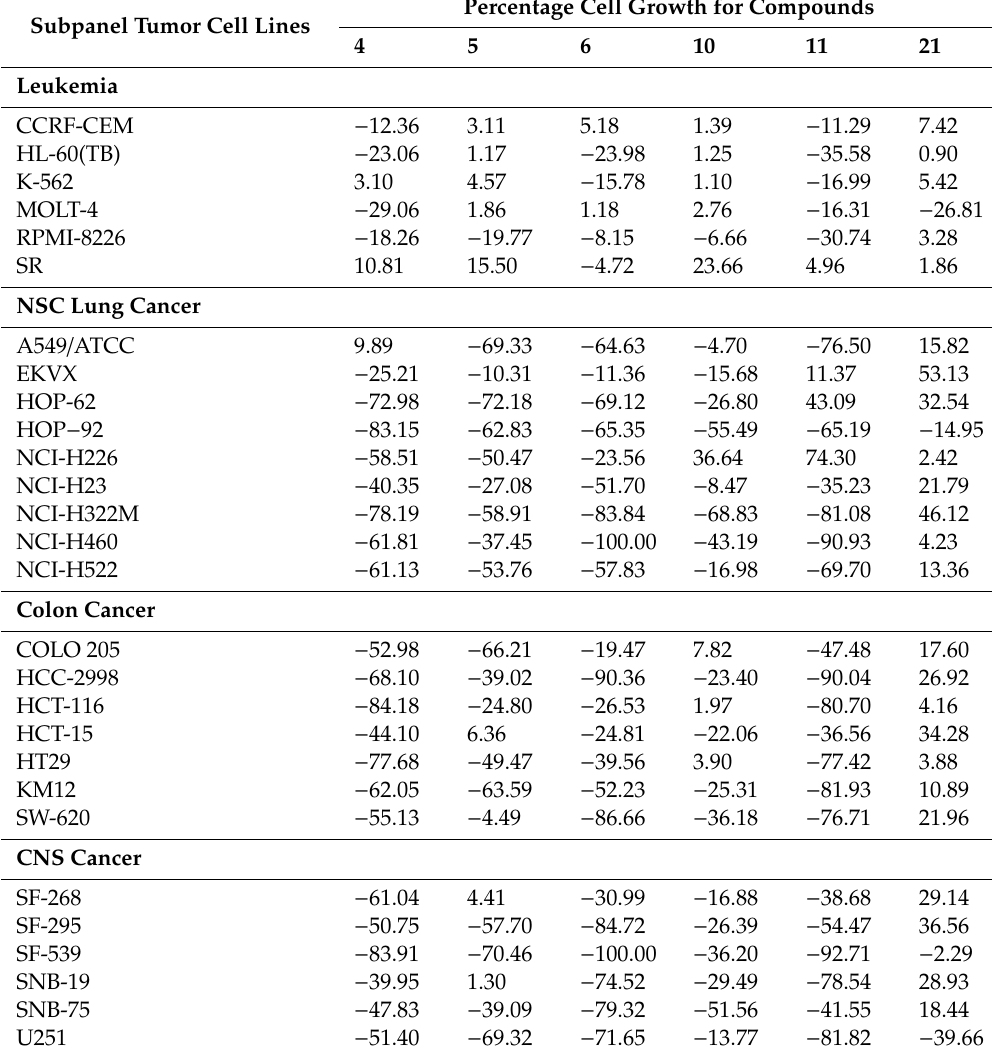
Table 2. Percentage cell growth of sixty human tumor cell line anticancer screening data of the